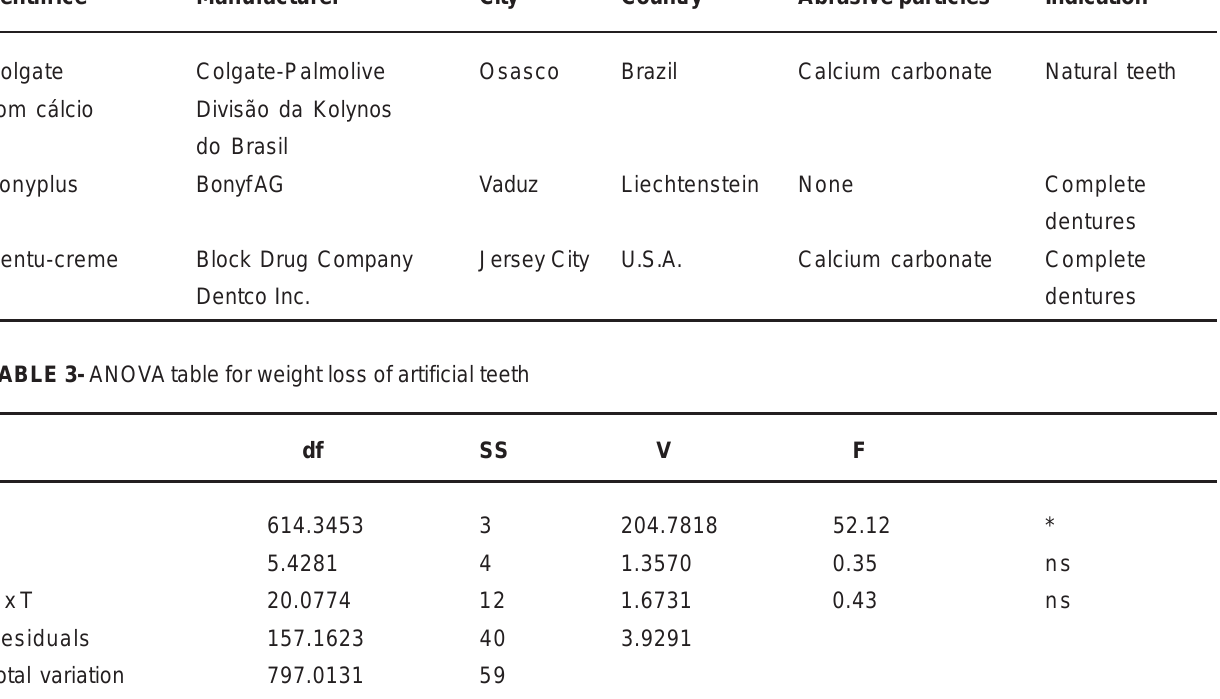
D: dentifrices; T: artificial teeth; *: P<0.05;